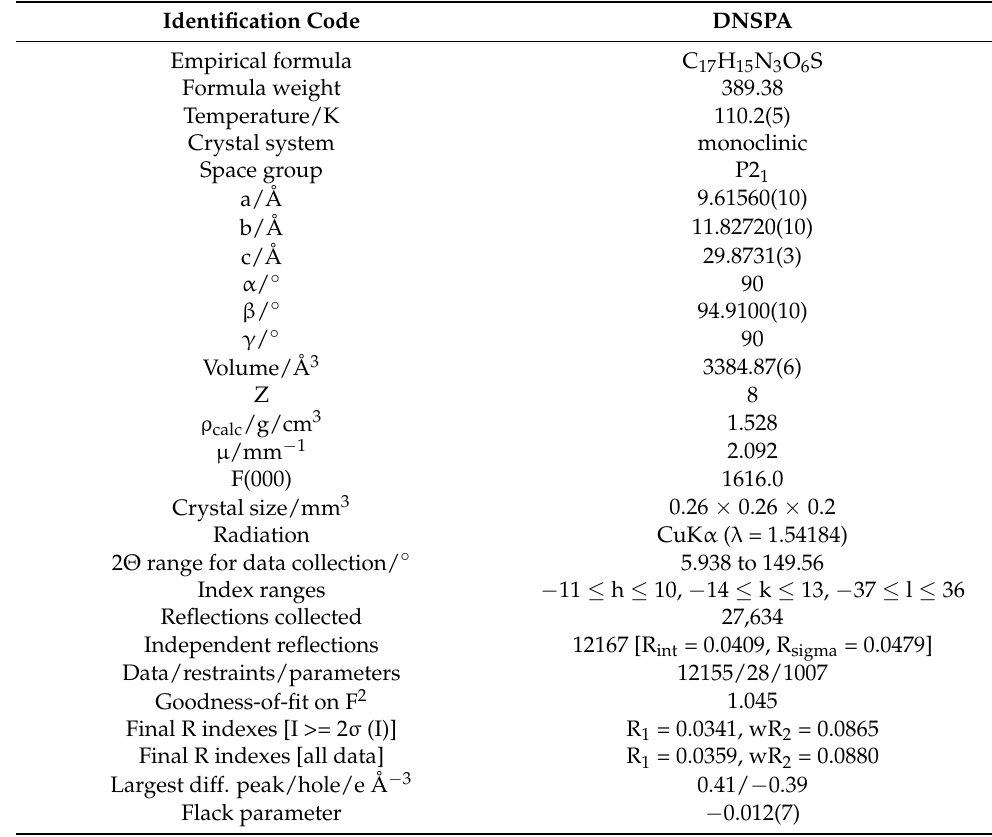
Table 6. Crystal data and structure refinement for